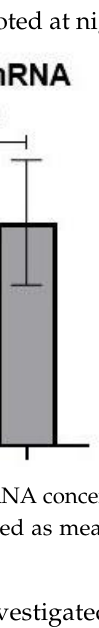
Figure 3. Effect of single and repeated blast exposure on Tph1 and Tph2 mRNA levels at night in the pineal glands of SD rats. Tph1 mRNA concentrations at ( A ) 6 h, ( B ) 24 h, and ( C ) 1 month after blast injury. Tph2 mRNA concentrations at ( D ) 6 h, ( E ) 24 h, and ( F ) 1 month after blast injury. Results are expressed as means ± SEM (n = 6); ** p < 0.01 and * p < 0.05 for sham vs. single blast group; ## p < 0.01 and # p < 0.05 for sham vs. repeated blast group; ns — not significant.